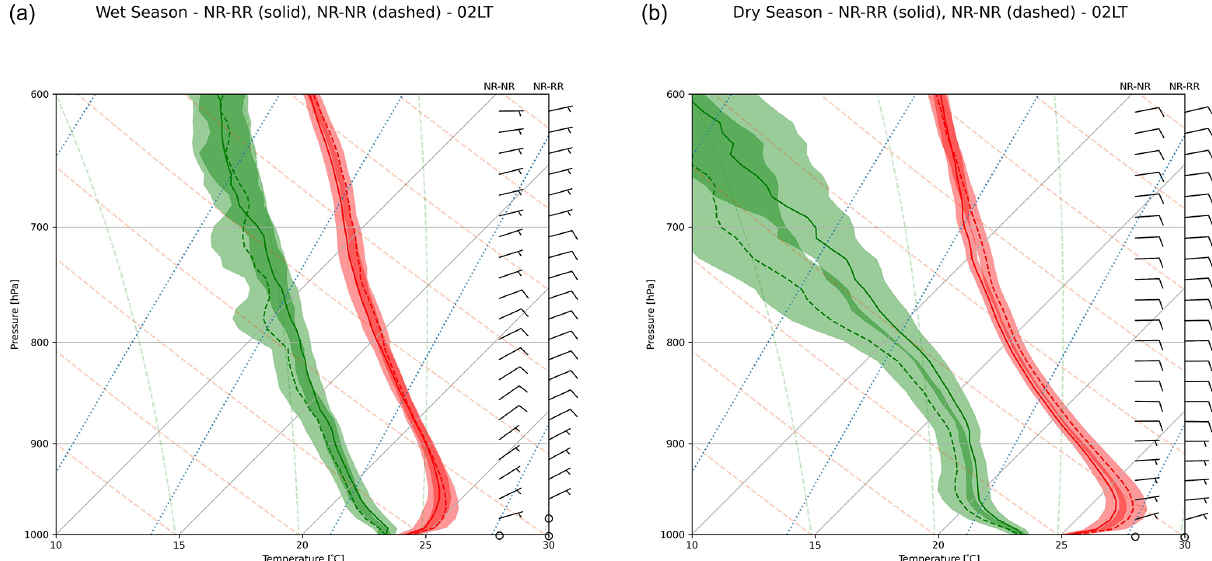
Figure 4. Composite 02:00LT radiosondes launched at T3: (a) wet season; (b) dry season. Solid lines are NR–RR data, and dashed lines are NR–NR data. The red line is dry temperature and green the dew point temperature. Shaded areas represent 1 standard deviation.